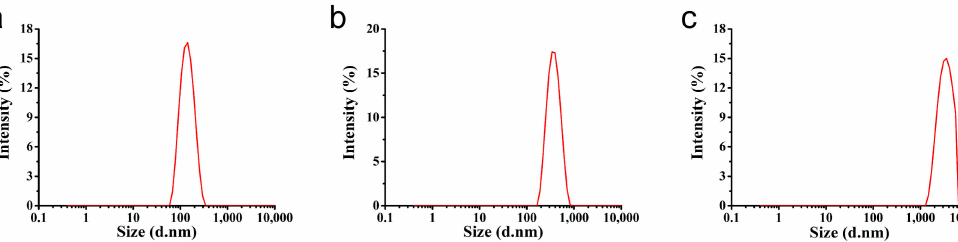
Figure 2. Schematic illustration of the preparation of poly(lactic acid) (PLA) microspheres (MSs).